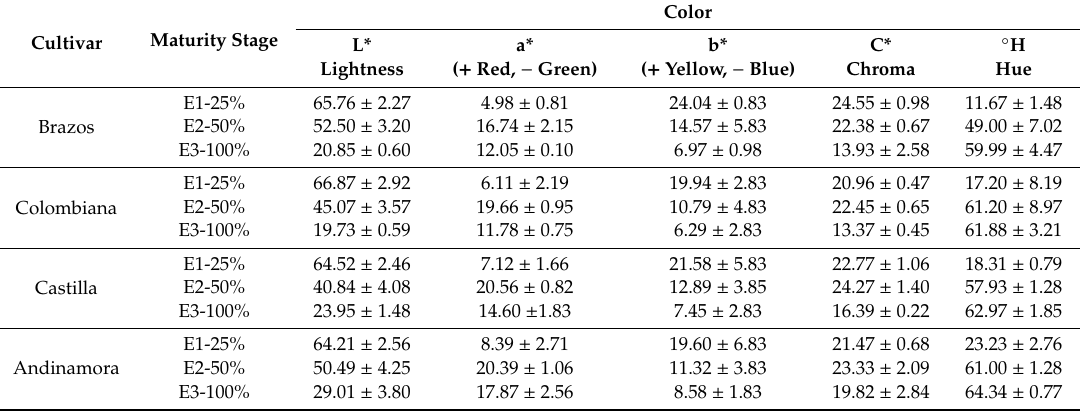
Table 1. Commission Internationale de l’Eclairage (CIE) (L* a* b*) color coordinates in four blackberry cultivars grown in Ecuador.